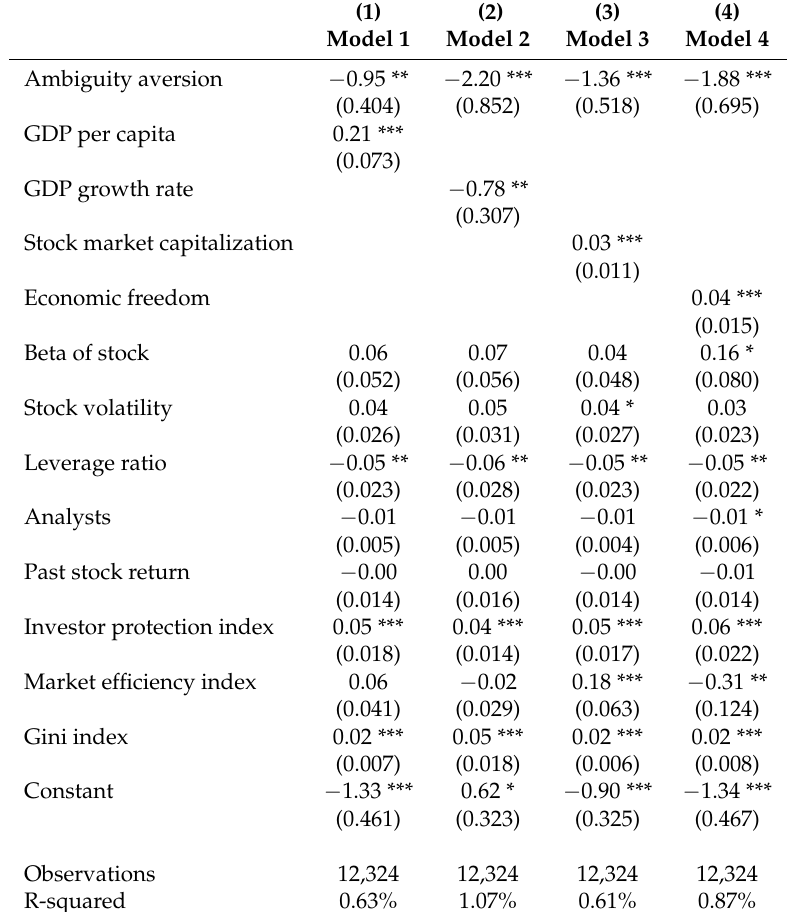
Table 8. Regressions with different controls for the equity premia and ambiguity